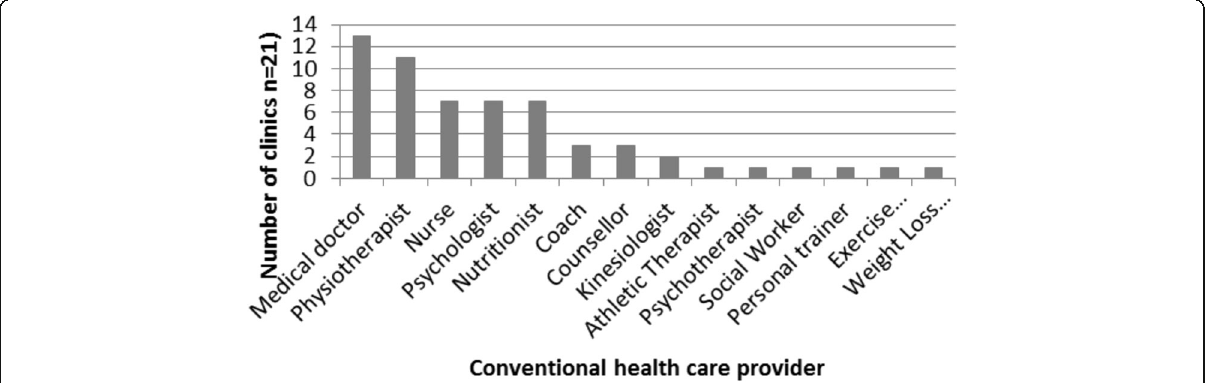
Fig. 2 Number of study sites providing services delivered by conventional health care